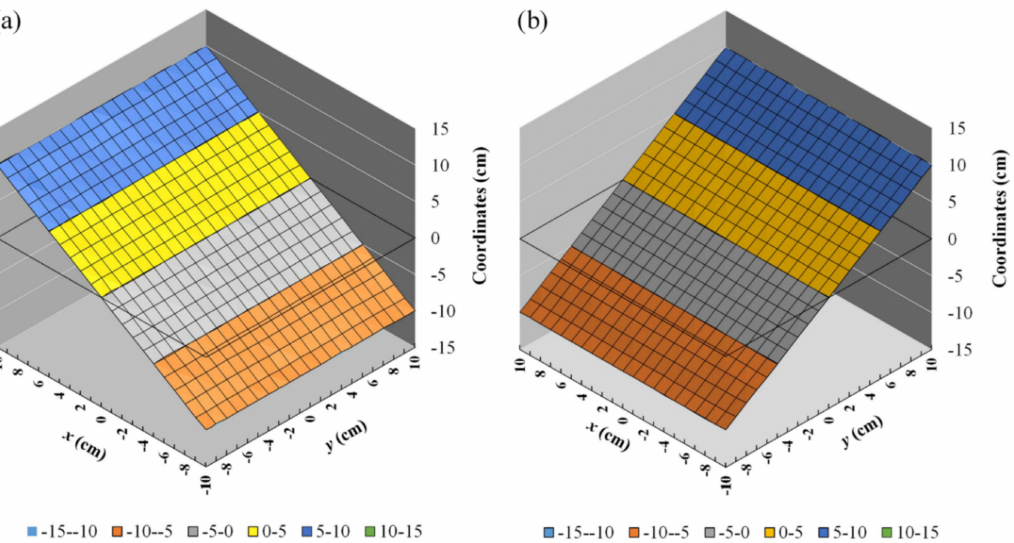
Figure 9. The coordinates converted from the field distribution along ( a ) x -axis and ( b ) y -axis after applying the linearity correction algorithm. The total number of data points is 21 × 21 = 441, and the grid size is 1 cm × 1